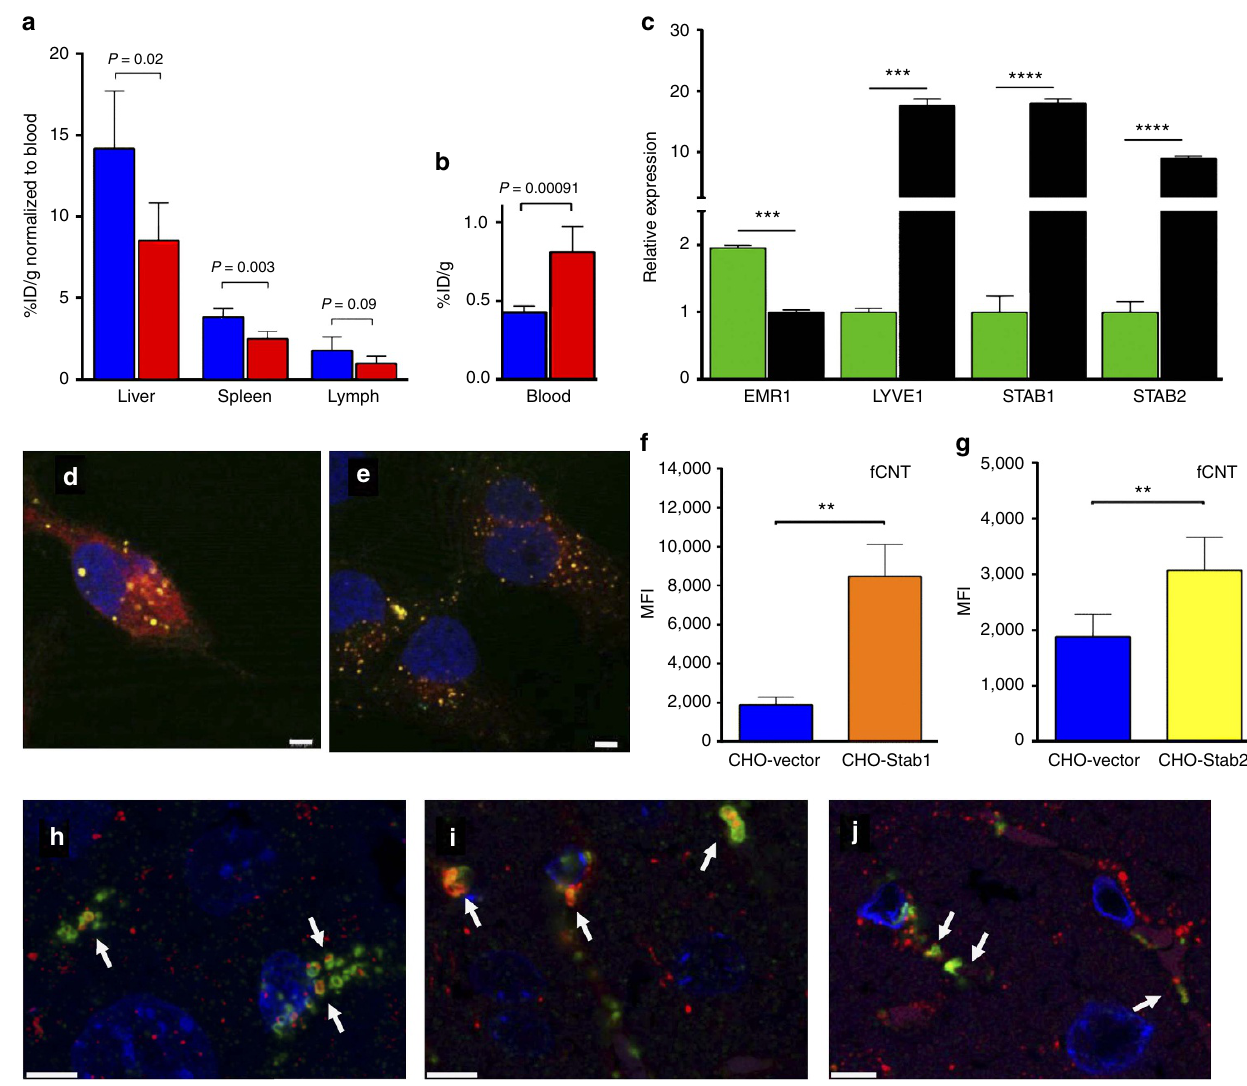
Figure 3 | Stabilin-mediated endocytosis of fCNTand LSEC trafficking. ( a ) Mice were administered 20mg heparin (blue bars) and 0.01mg fCNTshowed decreased fCNTaccumulation in liver, spleen and lymph nodes versus heparin null controls (red bars) and ( b ) concomitantly more fCNTremained in the blood of the heparin treated mice after 1h. ( c ) PCR analysis of LSEC (black bars) and Kupffer cells (green bars) isolated from mouse liver showed that the LSEC strongly expressed mRNA for both Stabilin-1 and Stabilin-2. The phenotype of each cell type was confirmed by FACS analysis (Supplementary Fig. 10). Immunofluorescent confocal images of CHO cells transfected with full-length human ( d ) Stabilin-1 (scale bar, 2.80 m m) or ( e ) Stabilin-2 (scale bar, 4.38 m m) expressing cells were stained with anti-Stabilin-1 and anti-Stabilin-2 antibodies (red) and anti-AF488 (green) to mark fCNT appended with AF488, and DRAQ5 to mark nuclei (blue). Punctate cellular structures with co-localized staining were evident in both cases. FACS analysis quantified bound and internalized fCNT in the CHO-transfected ( f ) Stabilin-1 (orange bar) and ( g ) Stabilin-2 (yellow bar) cells versus CHO transfected with an empty vector (blue bar, negative control). The bars are mean ± SD using data from 6 experiments (** P o 0.01). acLDL served as a positive control (Supplementary Fig. 13). Organelle trafficking of intracellular fCNT (anti-AF488 (green)) was observed within LSEC in mouse tissue in punctate patterns and was shown through co-staining to be associated with different intracellular organelles as a function of time. 3D-rendered confocal images of the ( h ) early endosome (EEA-1, red) at 5min after injection; ( i ) Golgi compartments (Giantin, red) at 40min; and ( j ) lysosomes (LAMP1, red) at 1 day. A complete time course of these representative data is shown in Supplementary Fig. 14. White arrows indicate co-localized AF488 signal with respective organelles. GM130 stained tissue data correlated with the Giantin stained sections and LAMP2 lysosome marker data (not shown) correlated with LAMP1. The nuclei are stained with DAPI (blue) and scale bars, 5 m